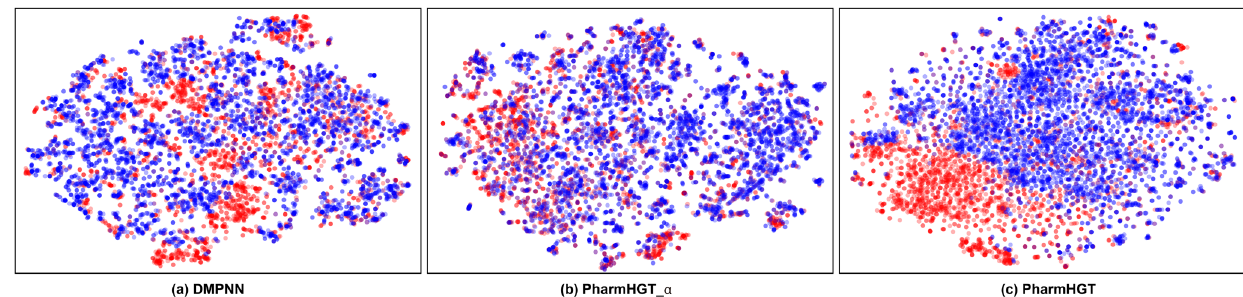
Fig. 4 Visualization of molecular features. Visualization of molecular features for Tox21 from a DMPNN, b PharmHGT_ α , and c PharmHGT with t-SNE. All molecules with a label of 0 as non-toxic compounds, and any molecule with a label of 1 as a toxic compound, where toxicity compounds are colored in red and the non-toxic ones are